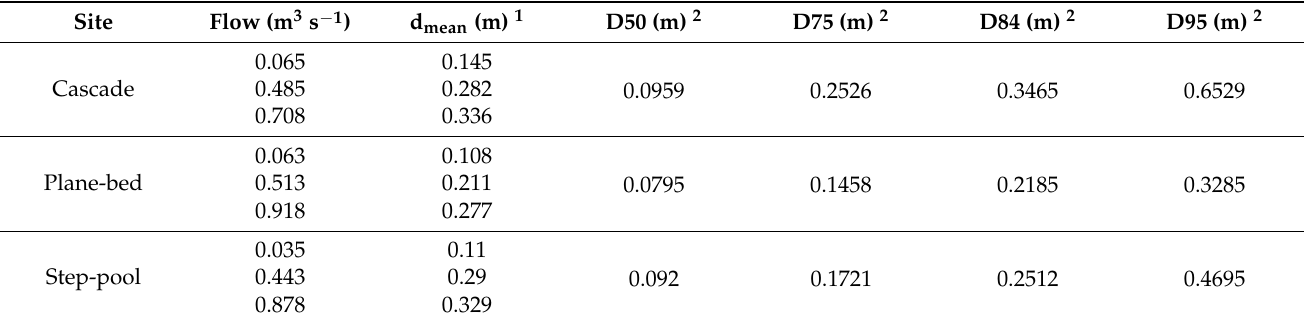
Table 3. Bed material quartiles and mean depth for each morphology and flow